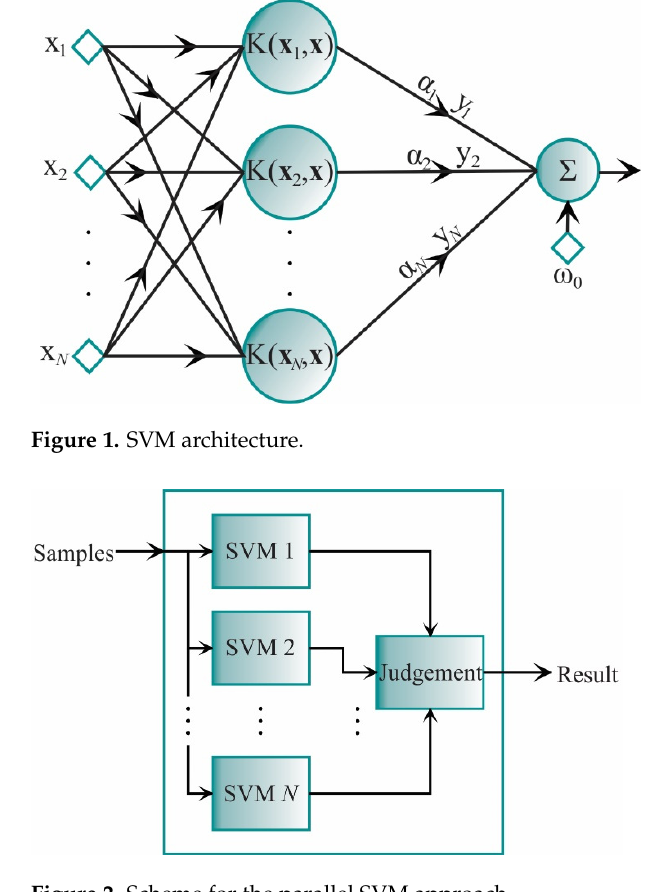
Figure 2. Scheme for the parallel SVM approach.